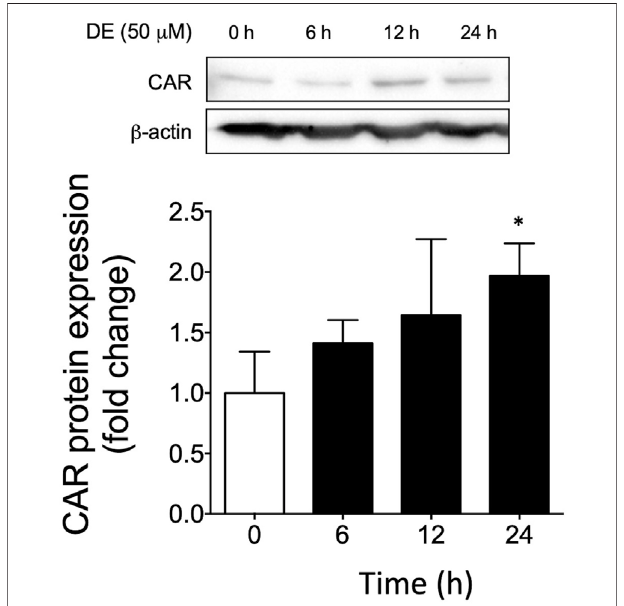
FIGURE 6 | DE causes nuclear translocation of CAR protein. Primary mouse hepatocytes were treated with 50 μ M DE for 0, 6, 12, and 24 h. (A) Western blot analysis of nuclear CAR protein from DE-treated primary mouse hepatocytes. β -actin protein levels are shown as a control for protein loading.The western blotrepresentsonereplicateofthree samples.All values represent the mean ± SEM (n (cid:2) 3 hepatocyte cultures from different mice) normalized against the control levels and quanti fi ed by densitometry. Mean difference is signi fi cant from the control group at * p ≤ 0.05.